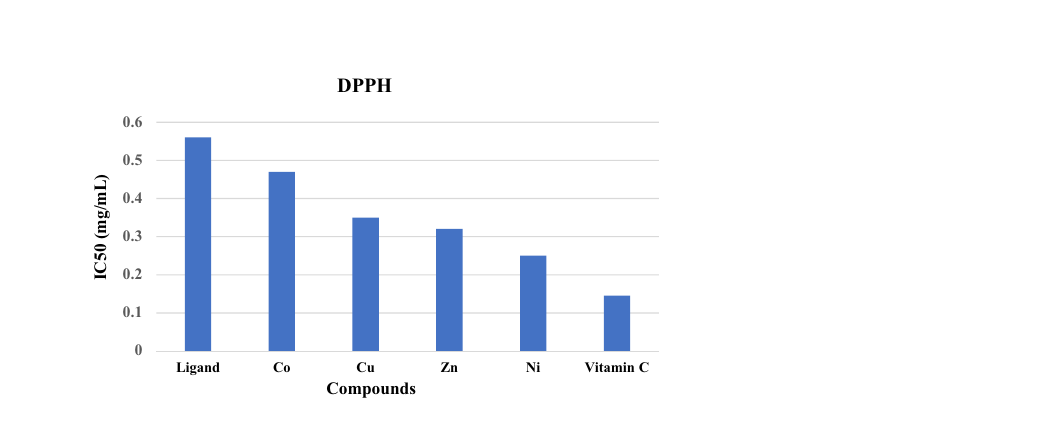
Table 3. The effect of the ligand and its complexes cobalt (Co), copper (Cu), zinc (Zn) and nickel (Ni) on the antioxidant DPPH at different concentrations (0.05–0.5 mg/mL).